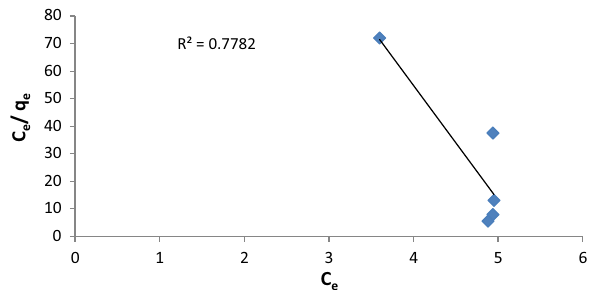
Fig. 8 Langmuir isotherm plot on sorption of Estuary crude oil onto FBPC